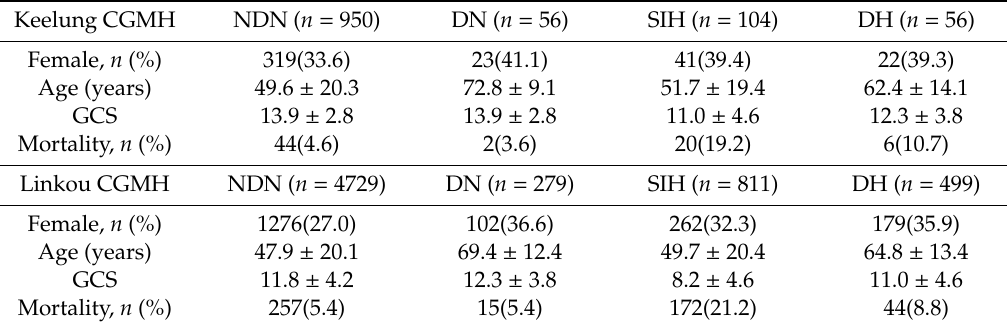
Table 1. Demographics and outcomes of the enrolled patients with traumatic brain injuries in each hospital categorized into four groups (NDN, DN, SIH,